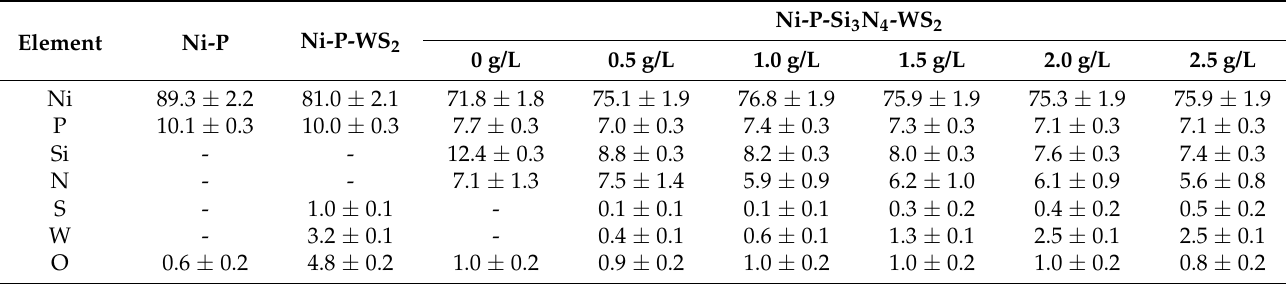
Table 2. Chemical composition of Ni-P, Ni-P-WS 2 and Ni-P-Si 3 N 4 -WS 2 coatings (mass